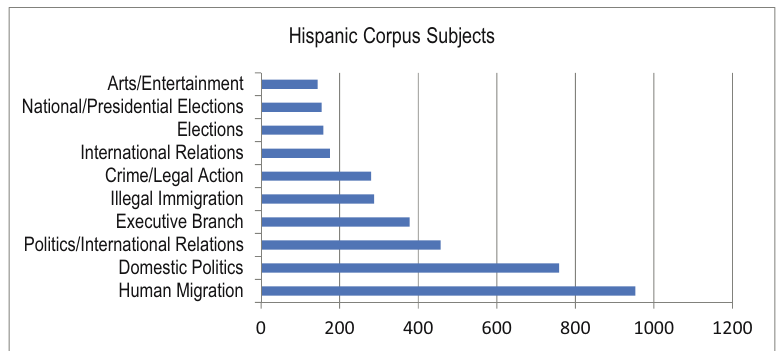
Figure 2: Most mentioned topics in the Hispanic corpus.